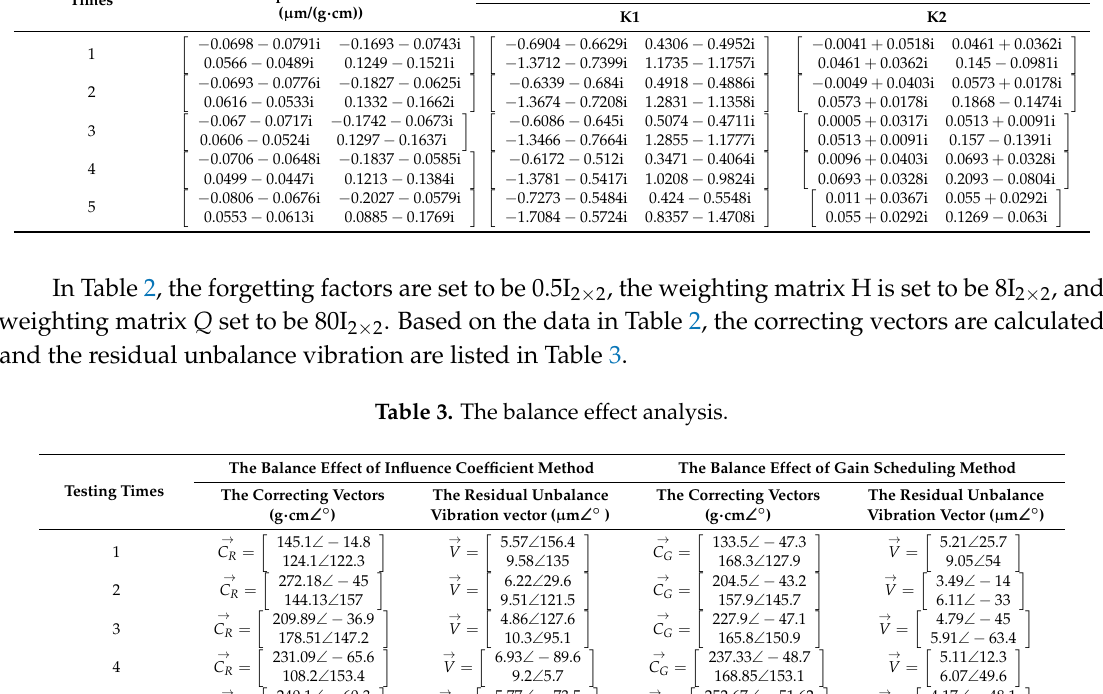
Table 2. The self-adaptive process of influence coefficient and gain parameter. Times The Self-Adaptive Influence Coefficient ( µ m/(g · cm))